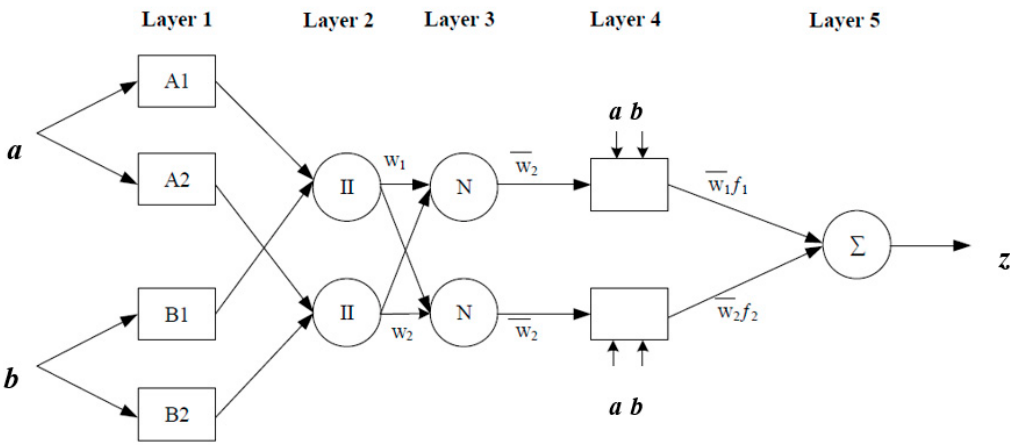
Figure 6. Adaptive neuro-fuzzy inference system (ANFIS) architecture [28].